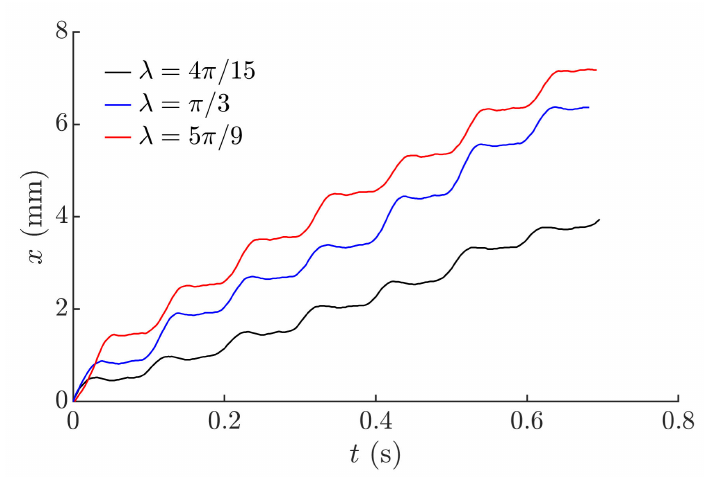
Figure 11. Captured trajectories of the microminiature body at different values of λ when φ = π /10, A = 0.6 mm, ω = 62.83